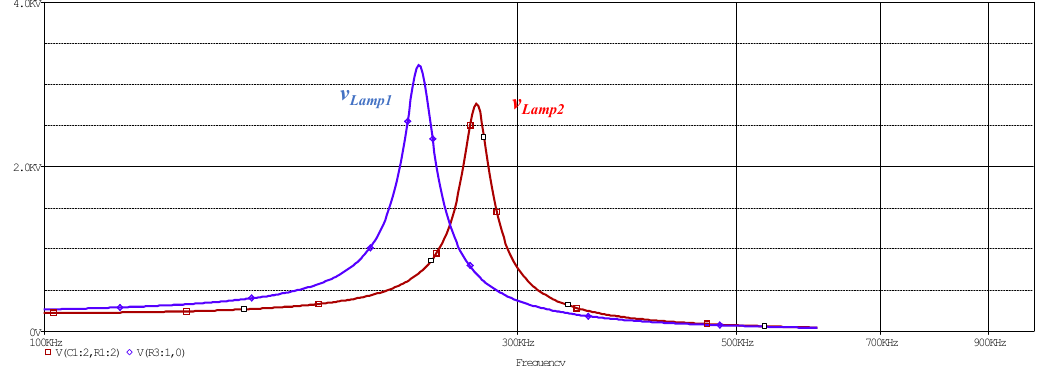
Figure 11. RI output voltage during the start-up of the EFL lamp: v lamp1 , considering only a resistive load and v lamp2 , considering the LR model (Inductance-resistance) of the lamp.